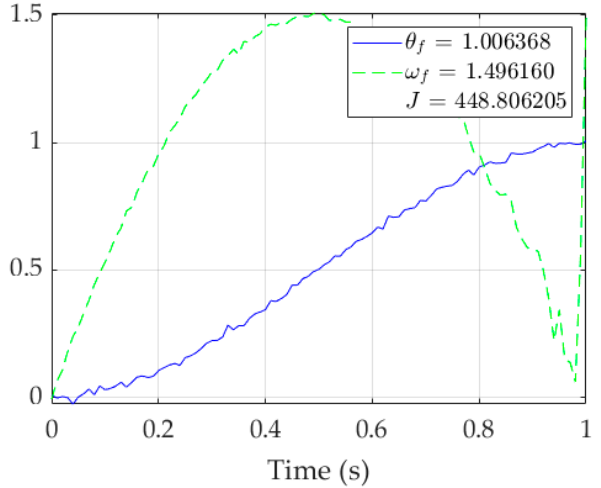
Figure 5. Singular run of RTOC using pinv ( A ) without open-loop switching. Note the deterioration in ω ( t ) starting after time = 0.8 s, indicating the function’s inability to reliably solve the system as it approaches singularity.